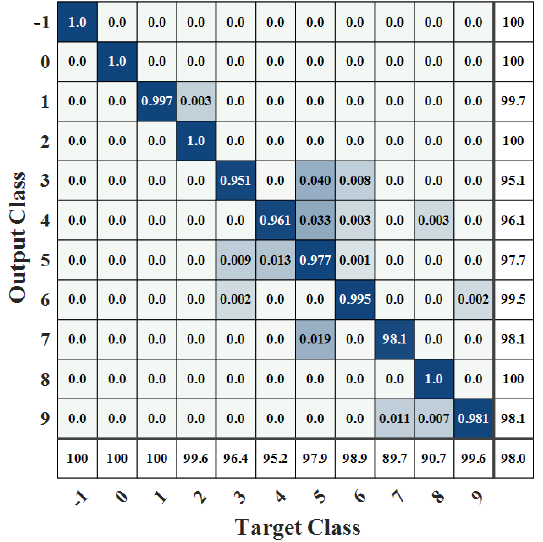
Figure 6. Confusion matrix 1 of working condition recognition.